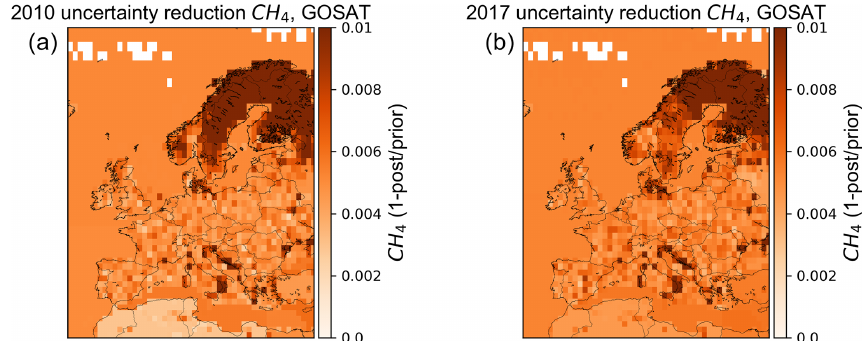
Figure 9. CTE-CH 4 GOSAT inversion run; uncertainty reduction maps computed as (1 − (cid:49) post /(cid:49) prior) for 2010 (a) and 2017 (b) .